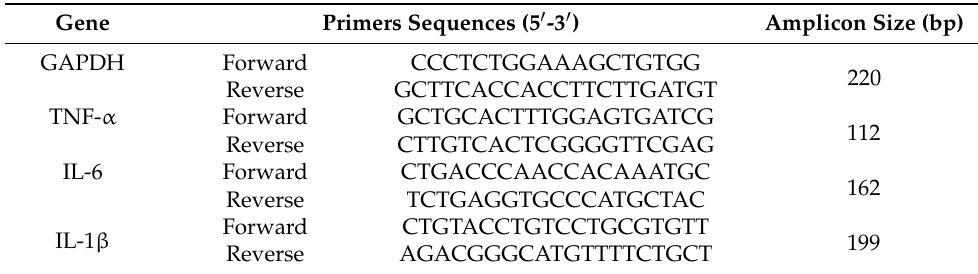
Table 2. The primers sequences in